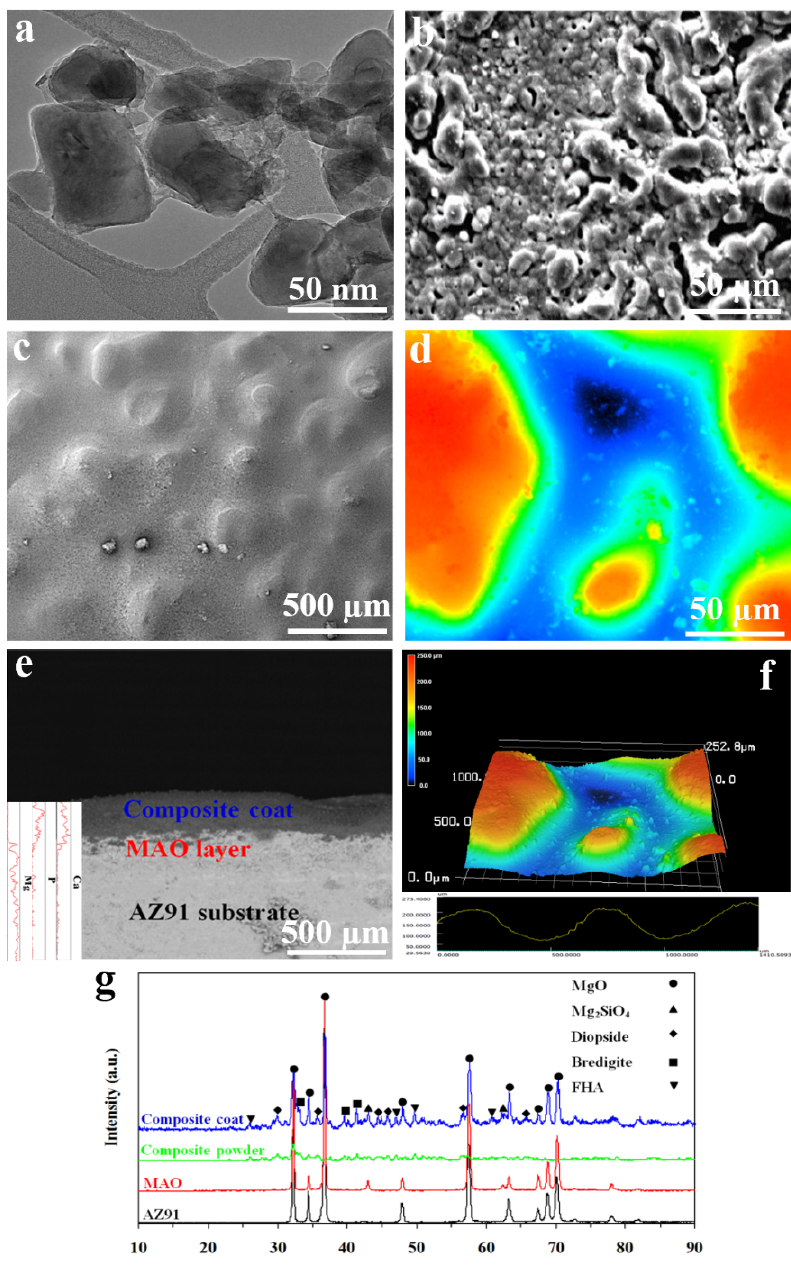
Figure 3. Microstructure characterizations: ( a ) TEM image of composite nanoparticles showing their size which was 50 ± 20 nm; ( b ) SEM image of a MAO treated AZ91 sample showing its rough and porous structure; ( c – f ) SEM (c,e) and LSM ( d , f ) images from top ( c , d ) and cross-section ( e , f )